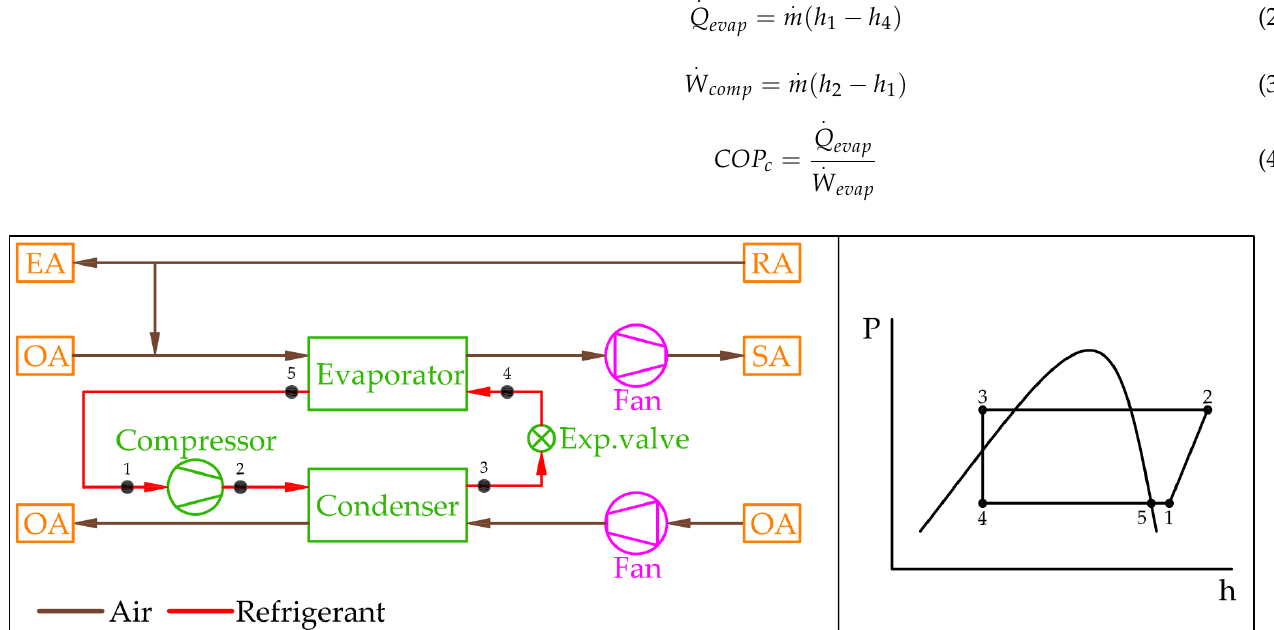
Figure 3. Configuration and P – h diagram of a general heat pump system.